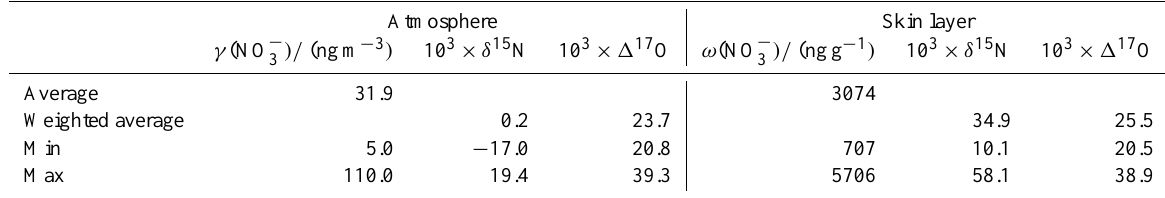
Table 4. Simulated nitrate concentration and isotopic composition at the air–snow interface in the case of the DC realistic simulation.